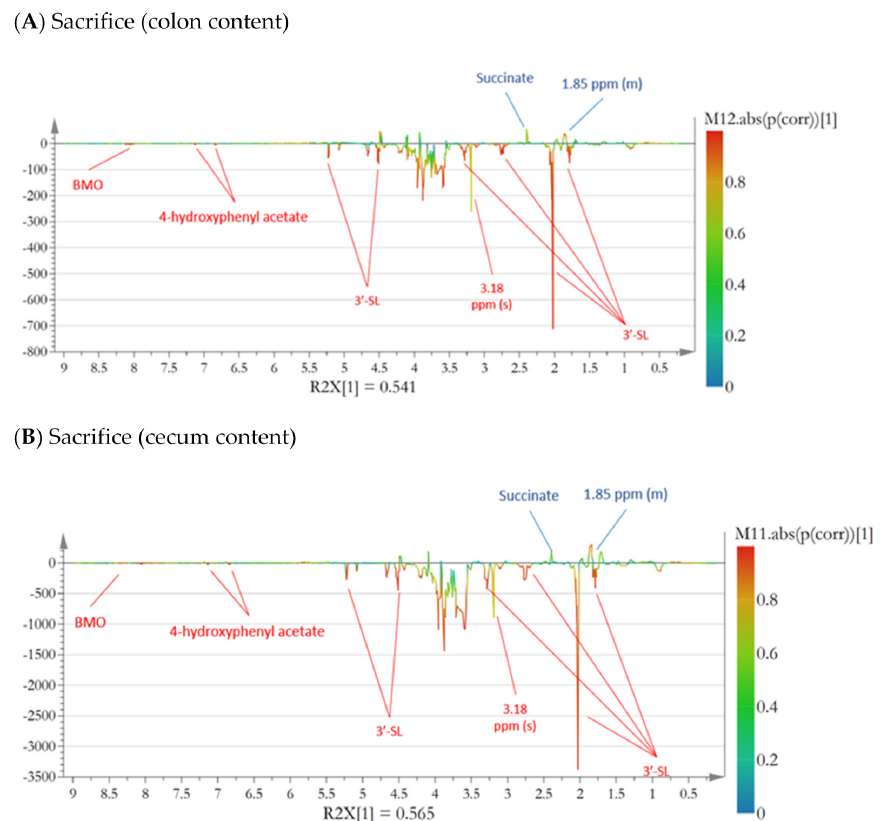
Figure 4. S-line plot from OPLS-DA showing 1 H NMR metabolomics data from samples collected at sacrifice. Positive resonances are correlated to CON treatment and negative resonances are correlated to BMO treatment. Color of the line indicates the significance of correlation. The OPLS-DA model validated using full-cross validation (leave-one-out) and each included one predictive and one orthogonal component, ( A ) Colon content, (Q2-value = 0.903), ( B ) Cecum content, (Q2 =